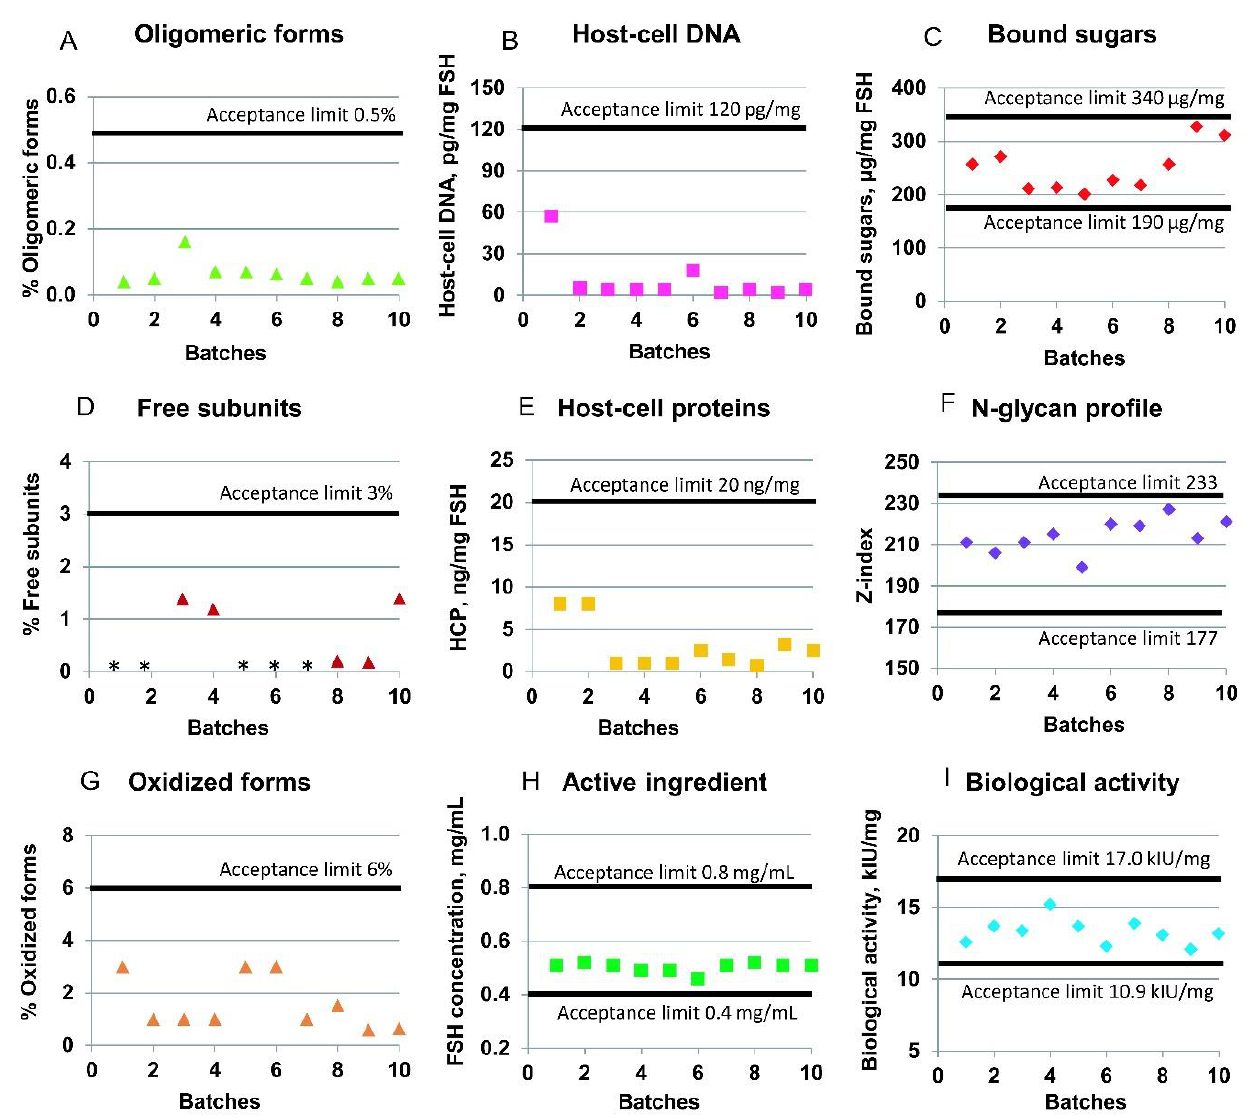
Figure 5. Quality control parameters of the r-hFSH drug substance. ( A ) Oligomeric forms content; ( D ) free subunit content; ( G ) oxidized forms content; ( B ) host-cell DNA content; ( E ) host-cell pro- teins (HCP) content; ( H ) level of the active ingredient; ( C ) bound sugars in the r-hFSH molecule; ( F ) N-glycan profile for r-hFSH; ( I ) biological activity of r-hFSH in vivo. * Value below the limit of quantification.